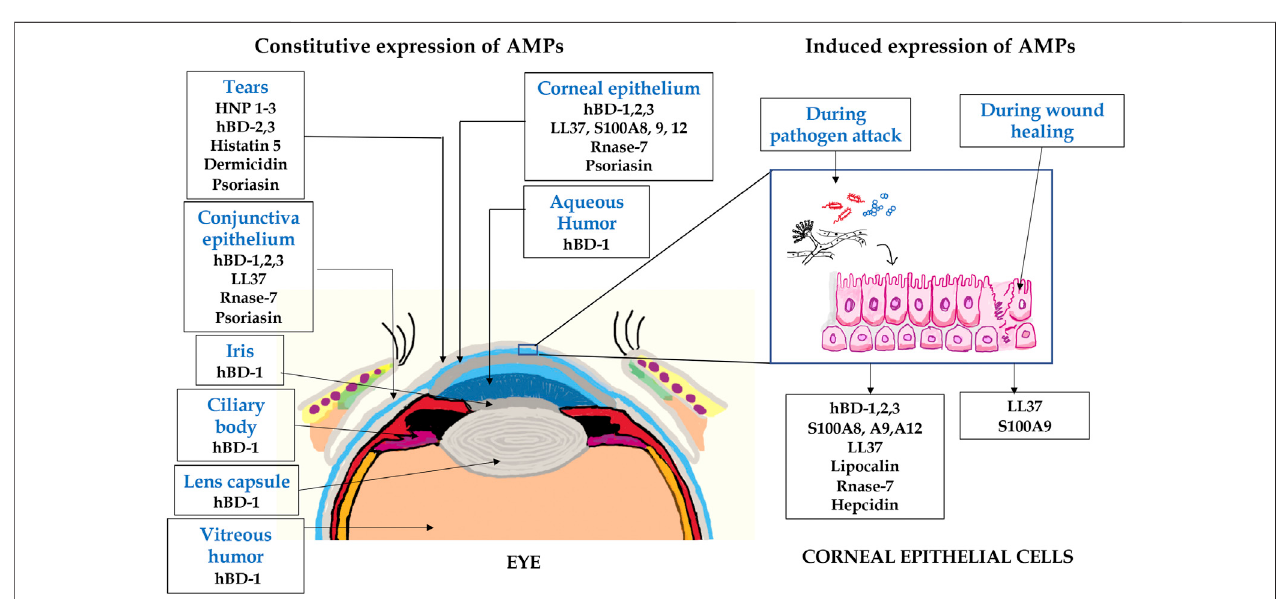
FIGURE 2 | A schematic representation of AMPs expressed in eye. The expression of several AMPs in the anterior part of the eye including tears, conjunctiva, iris, lens, aqueous humor, and corneal epithelium. The corneal epithelial cells express several AMPs constitutively or in response to pathogen attack and wound healing.